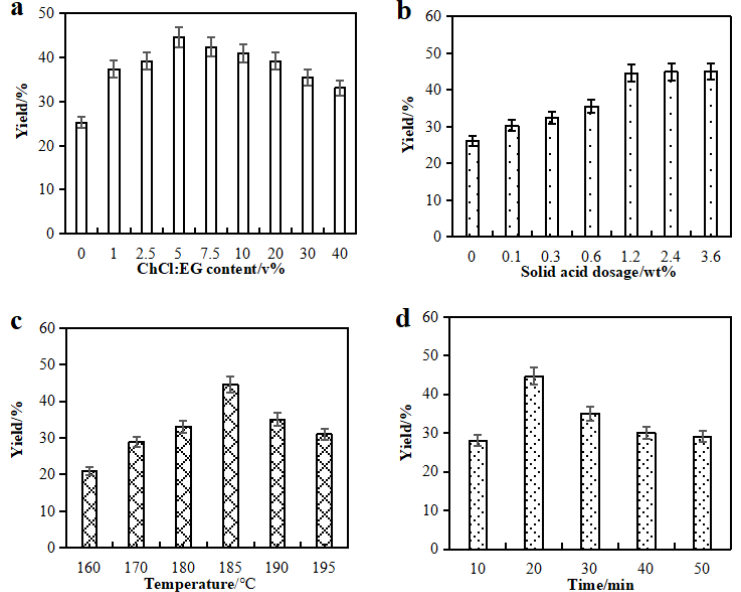
Figure 1. Effects of DES ChCl:EG (0–40 v%) on the FAL production via D -xylose dehydration ( a ); Effects of solid acid dose (0–3.6 wt%) on the FAL production via D -xylose dehydration in ChCl:EG–water (5:95, v / v ) ( b ); Effects of dehydration temperature (160–195 °C) on the FAL production via D -xylose dehydration in 20 min in ChCl:EG–water (5:95, v / v ) ( c ); Effects of dehydration time (10–50 min) on the FAL production via D -xylose dehydration at 185 °C in ChCl:EG–water (5:95, v / v ) ( d ).